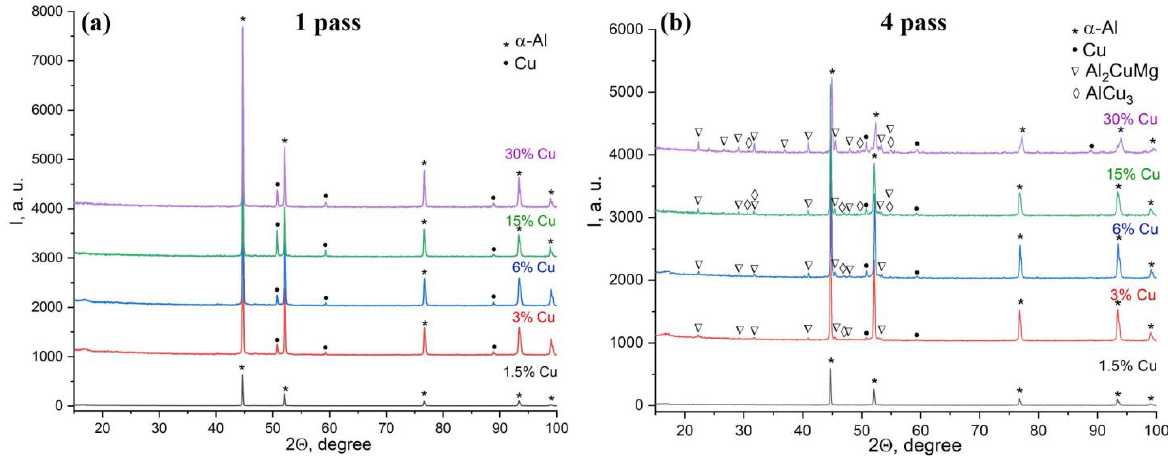
Figure 6. The XRD patterns of composite alloy samples made by 1-pass ( a ) and 4-pass ( b ) FSP. Mechanical characteristics such as ultimate tensile stress (UTS), yield stress (YS) and strain-to-fracture (STF) (Figure 7a–c) are presumably enhanced with the FSP pass number and the stir zone homogeneity. The UTS and YS become higher with the pass number for all the samples, except for those that are macrostructurally inhomogeneous even after 4 passes 30 vol.% Cu sample (Figure 7a,b). Nevertheless, the UTS of AA5056 after undergoing FSP stays absolutely maximum and increases with the pass number. The UTS of the 4-pass FSP 6.0 vol.% Cu sample is the closest to that of AA5056 (Figure 7a).